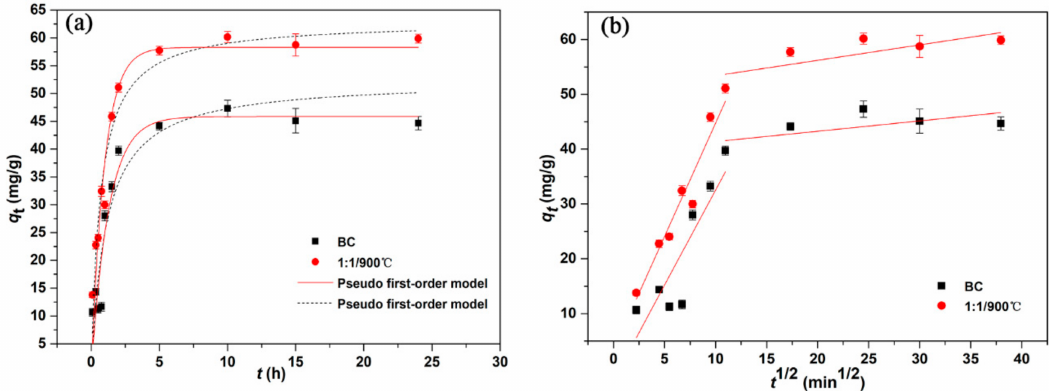
Figure 4. The adsorption kinetics study of E2 adsorption on BC and 1:1 / 900 ◦ C ( a ) The pseudo first-order and pseudo second-order kinetics, ( b ) Intra-particle di ff usion